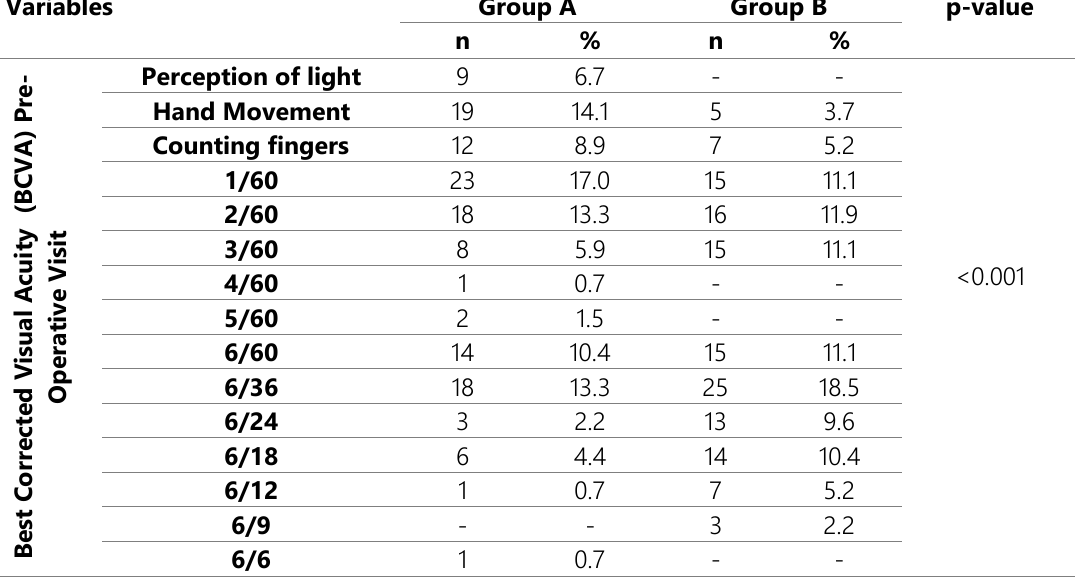
*p-value <0.05 is considered significant.